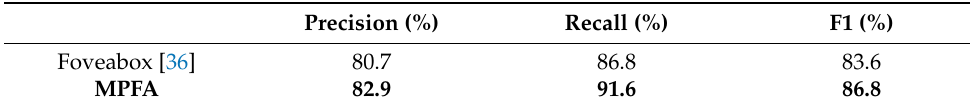
Table 8. Performance of a more precise foveal area in